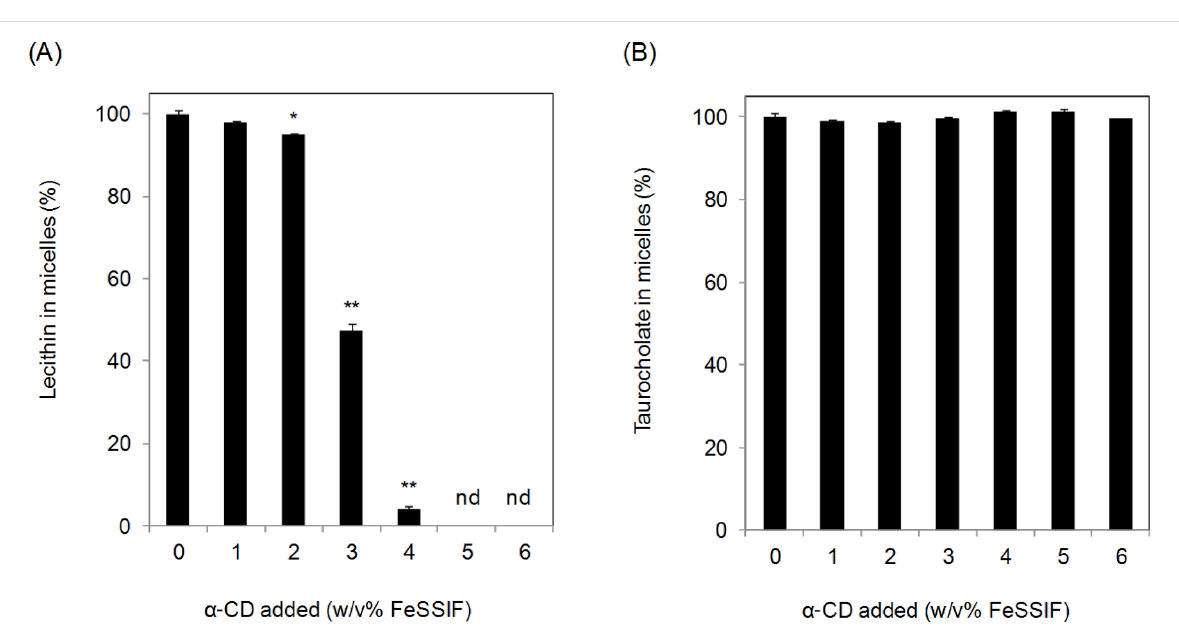
Figure 2: Effect of α -CD on the concentration of lecithin and taurocholate in the FeSSIF. After adding each amount of α -CD into 15 mL of FeSSIF (37 °C) and mixing for a few seconds, the mixture was shaken at 37 °C for 150 minutes at 100 rpm. The mixture was then filtered through a 0.2 μ m PTFE filter. Lecithin (A) and taurocholate (B) contents in the filtrate were measured. Means and standard errors are indicated ( n = 3). * P < 0.05, ** P < 0.01, significantly different from α -CD 0%. nd: not detected.